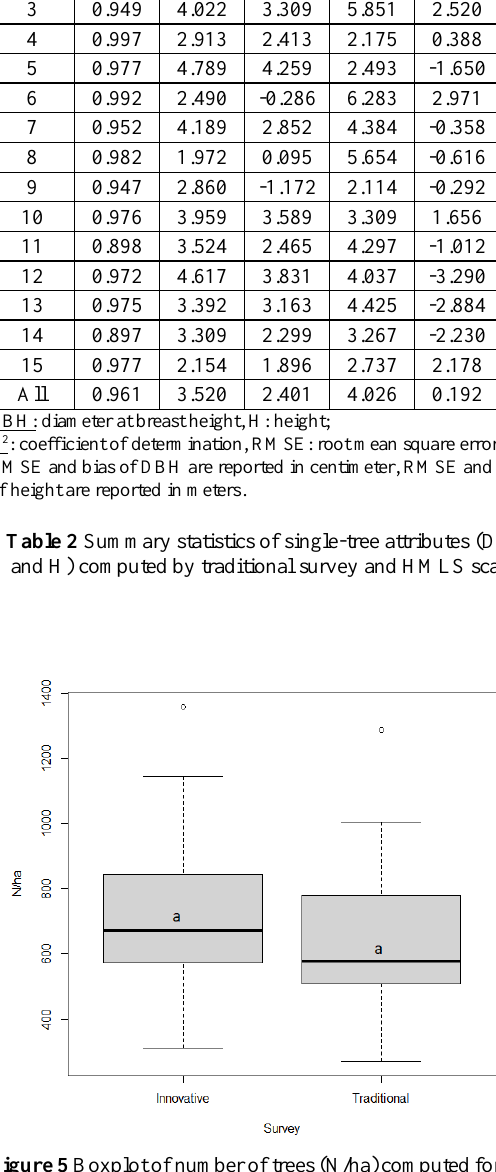
Figure 5 Boxplot of number of trees (N/ha) computed for each plot by traditional and innovative survey. Boxes with different letters indicate a statistically significant difference (p<0.05).